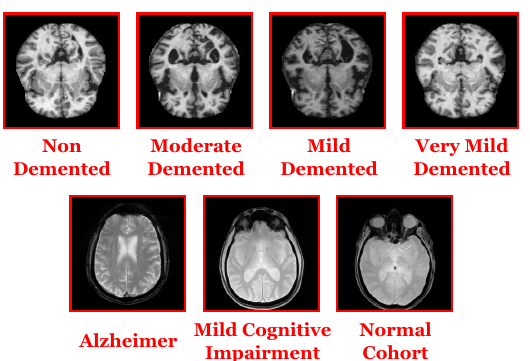
Figure 6. Samples from each used dataset in the current study.